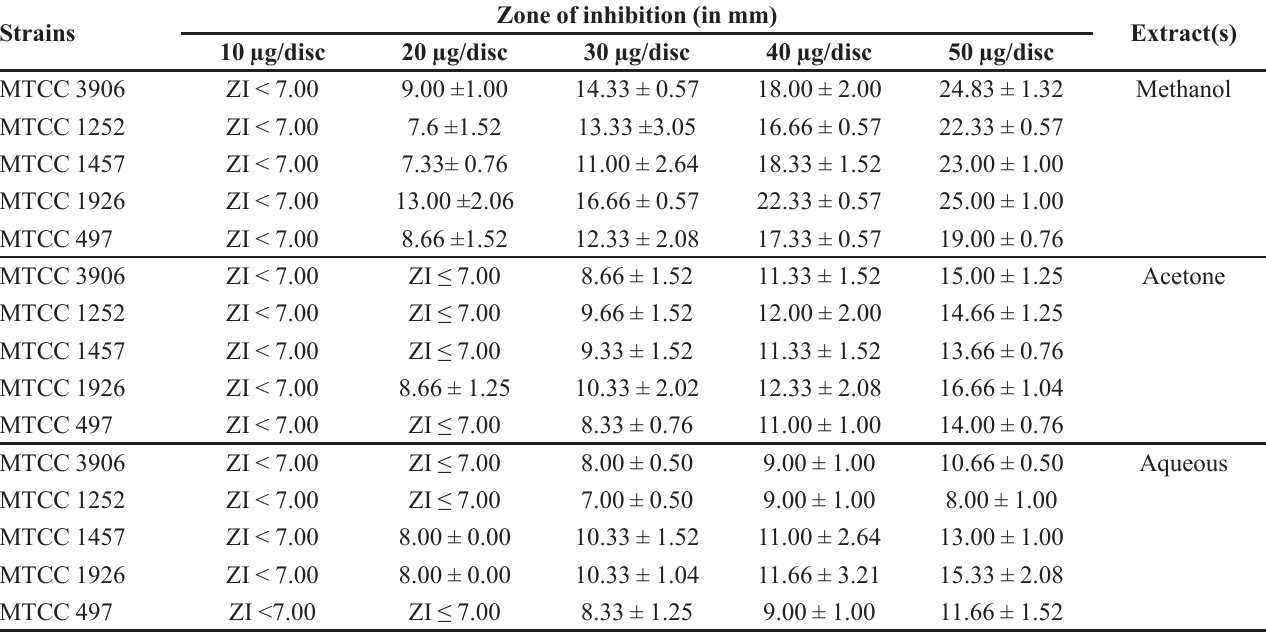
TABLE II - Antibacterial activity of D. Pentaphylla tuber extracts